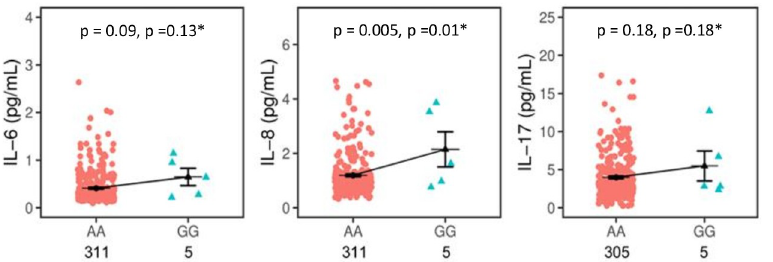
Fig 3. MIRNA499A rs3746444 effects on IL-6, IL-8, and IL-17 plasma levels between AA homozygous versus GG homozygous in healthy controls. Comparisons of circulating plasma levels of IL-6, IL-8 and IL-17 between the individuals AA and GG homozygous. The mean concentrations are displayed in picogram per millilitre (pg/mL) with standard error (SE) of mean. The means are represented by black bars, whereas SE are represented by error bars. � Corrected for Benjamini-Hochberg False Discovery Rate assuming three tests. p < 0.05 is statistically